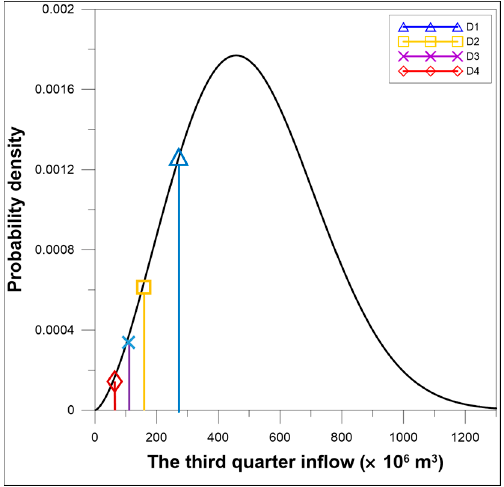
Figure 3. Example of estimating representative quarterly inflows corresponding to lower bounds of SII ranges of drought stages.